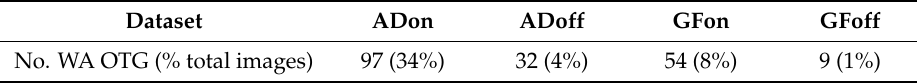
Table 5. The number of images categorized as WA OTG for each dataset.